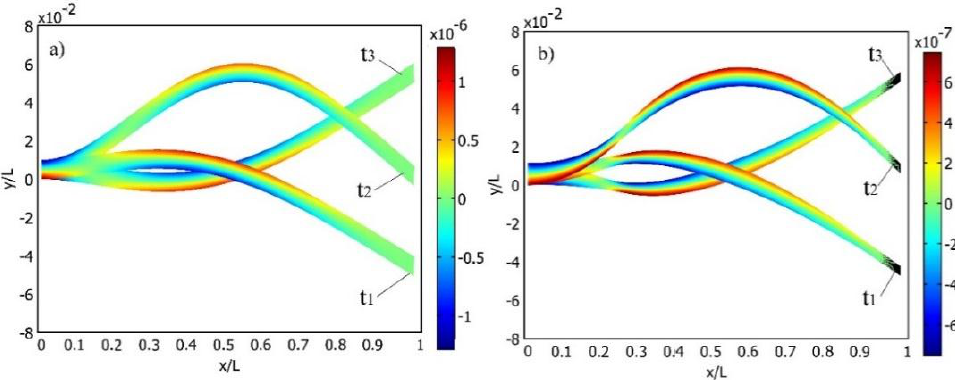
Figure 7. Mode shape and total normal strain distribution of the constant cross-section area cantilever at t 1 , t 2 and t 3 : ( a ) cantilever of a constant cross-section; ( b ) optimally-shaped cantilever.